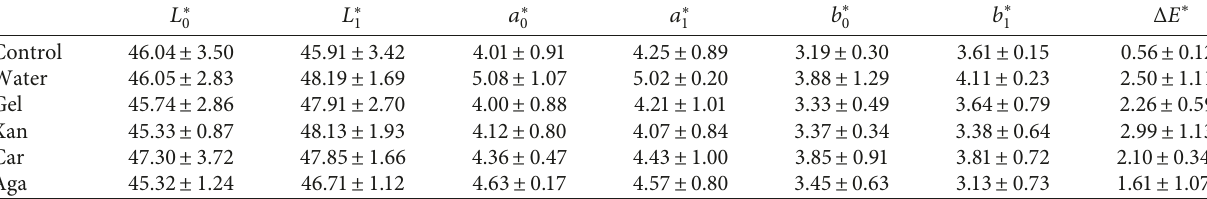
Table 2: Effects of different hydrocolloids on color assessment of porcine